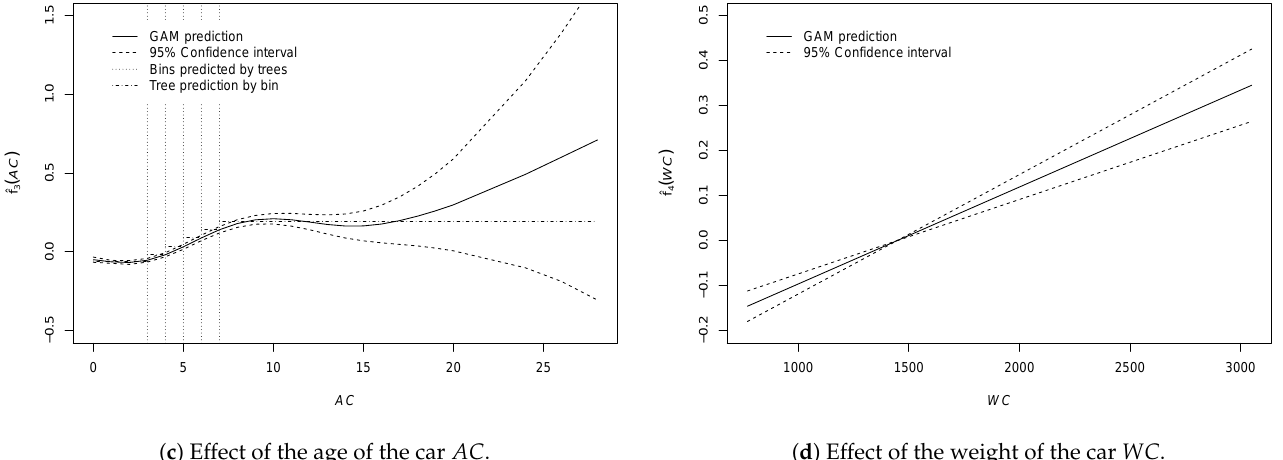
Figure 2. Illustration of the generalized additive models (GAM) effects ( ˆ f 1 , ˆ f 2 , ˆ f 3 and ˆ f 4 ) in Equation (1) and the bins obtained from evolutionary trees for the age of the policyholder AG , the horsepower HP , the age AC and the weight WC of the